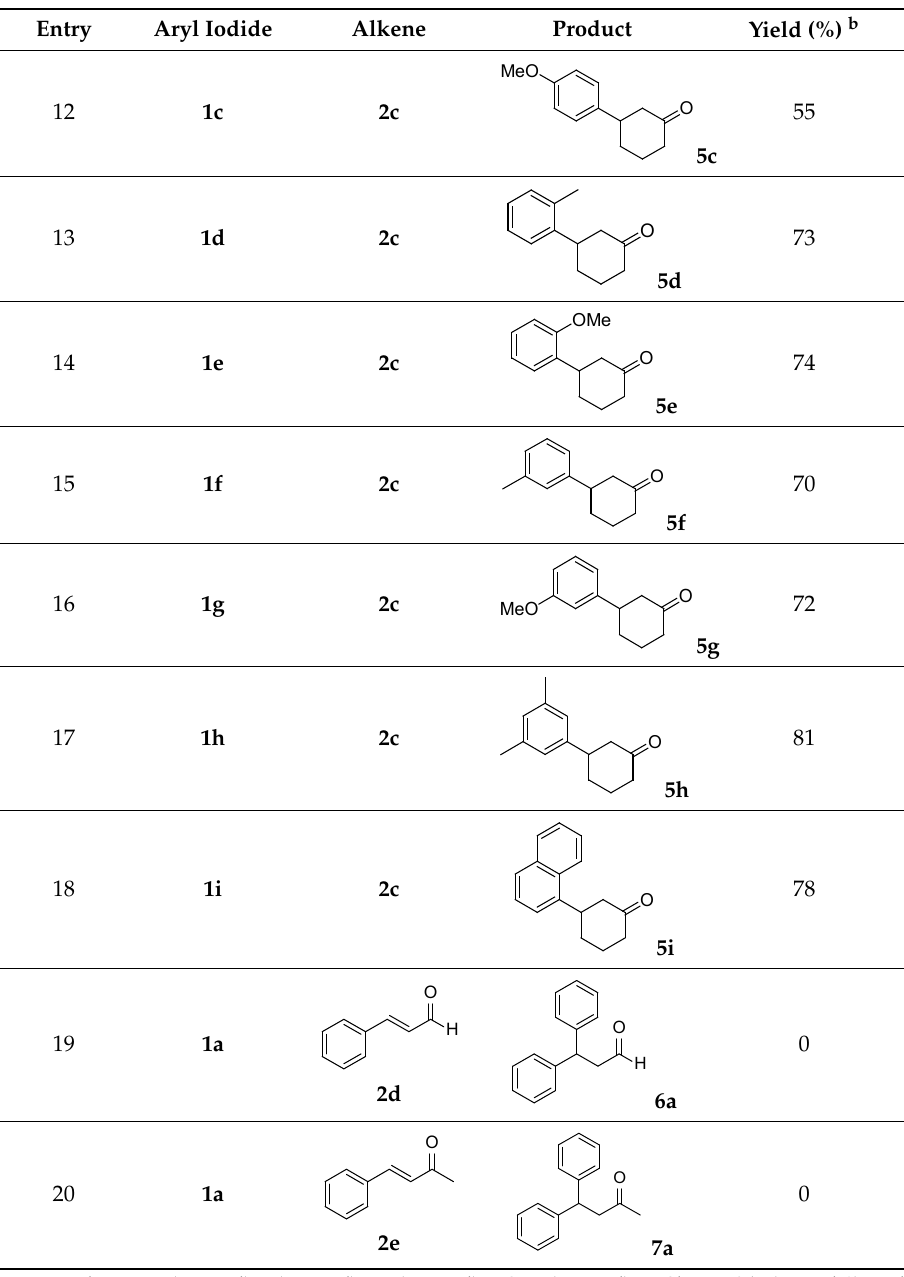
and H 2 O (3 mL) at 80 °C for 12 h. b Isolated yields.